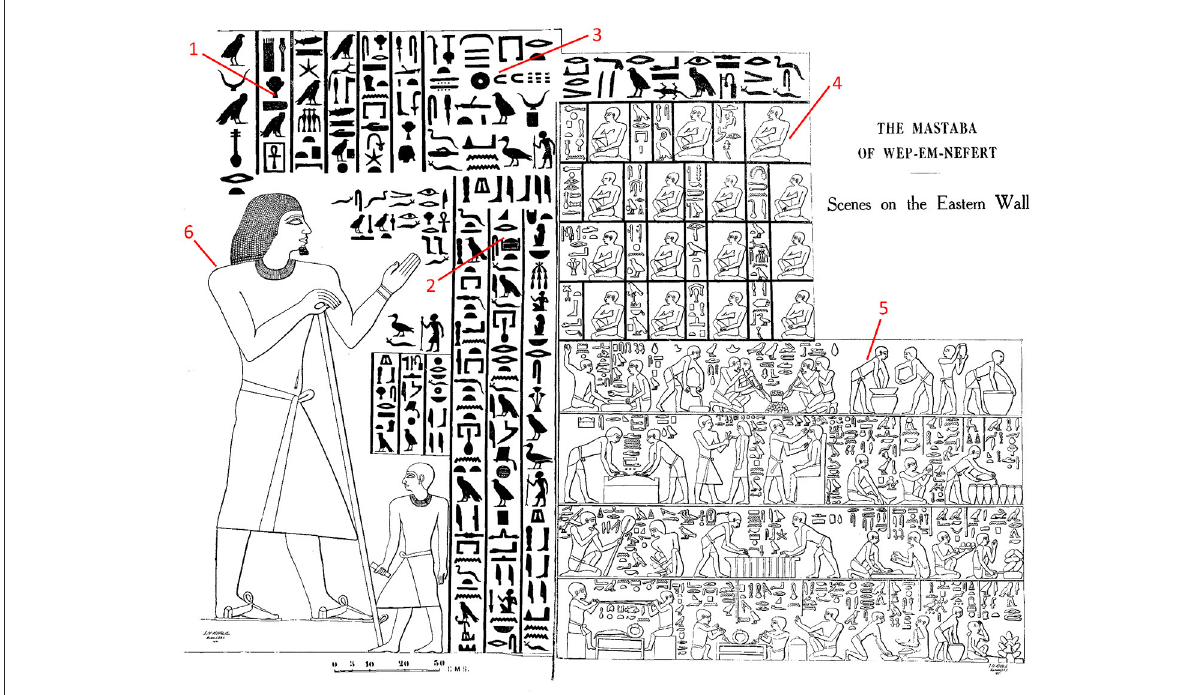
FIGURE1 Project B03: Mastaba of Wep-em-neferet (G 8882), Relief of Eastern Wall, from Hassan (1936, Vol. 2, p.